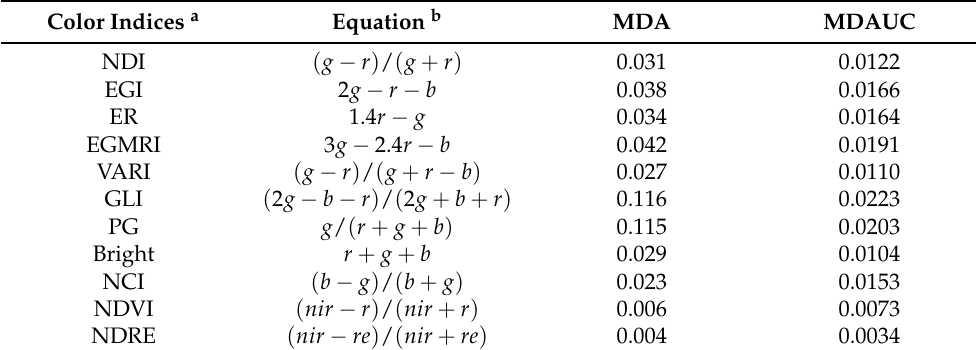
a PG = percent greenness, ER = excessive red, NDI = normalized difference index, EGI = excessive green index, EGMRI = excessive green minus red index, VARI = visible atmospherically resistant index, GLI = green leaf index, NCI = normalized color intensities, Bright = crown brightness, NDVI = normalized difference vegetation index, NDRE = normalized difference red edge index. b r = red band, g = green band, b = blue band, nir = near infrared band, re = red edge